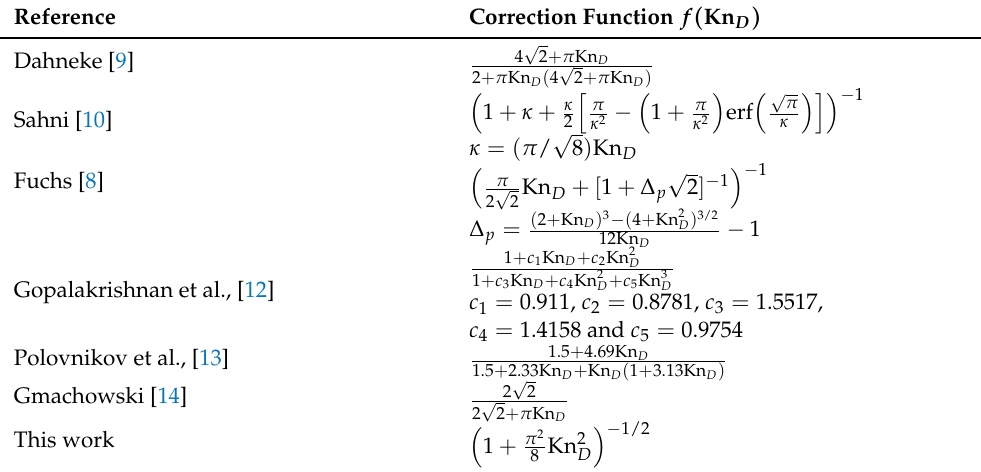
Table 1. Different approximations of the correction function f ( Kn D ) to calculate the coagulation kernels in the transition regime. The diffusive Knudsen number is given by Equation (7).